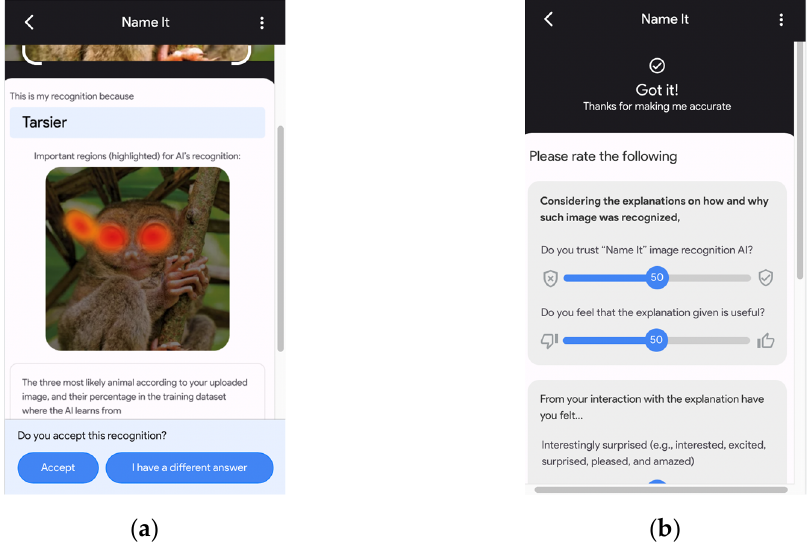
Figure 2. Sample screenshot of experiment testbed: ( a ) AI classification and XAI presentation of the image being recognized; ( b ) dependent variable sliders to be answered after classification.